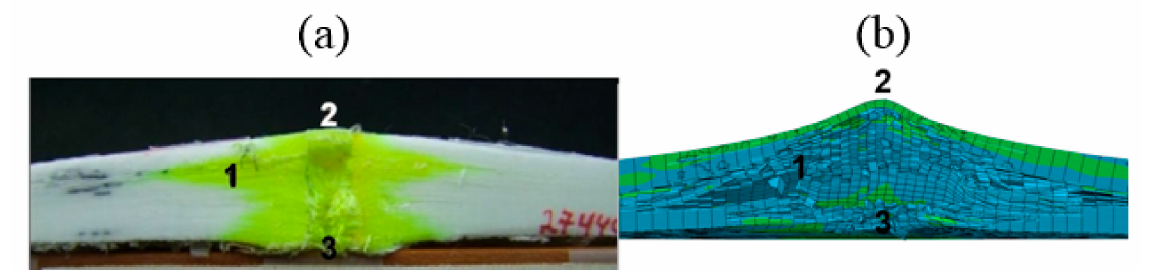
Figure 21. Plate section post-impact comparison (( a )—experiment; ( b )—analysis).